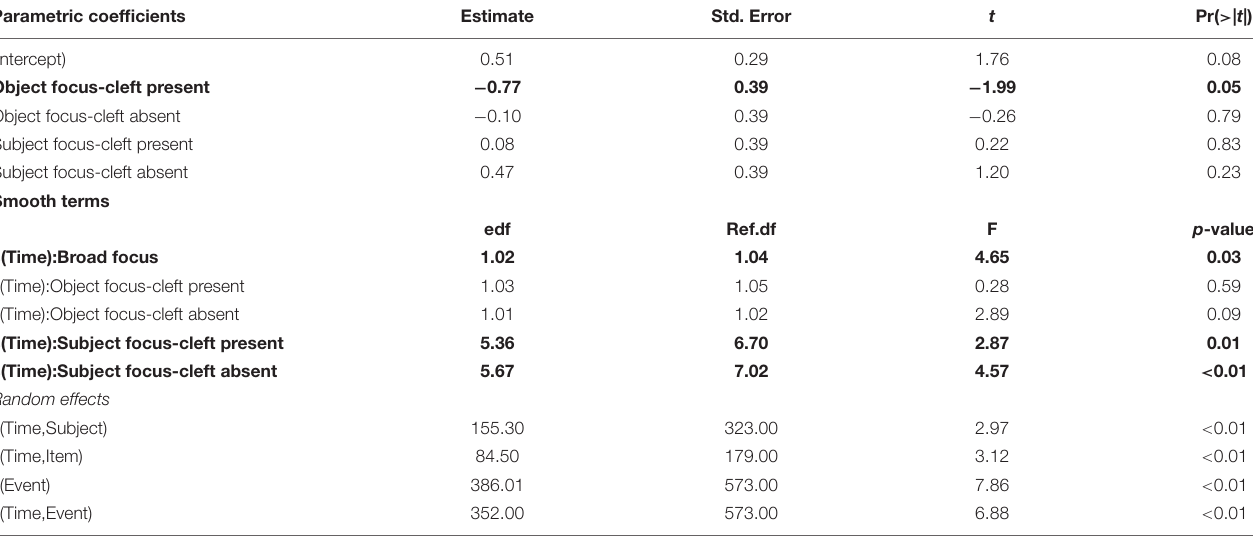
TABLE 3 | Summary statistics of the “Main” Generalised Additive Mixed Model for 3- to 6-year-olds. Parametric coefficients Estimate Std.